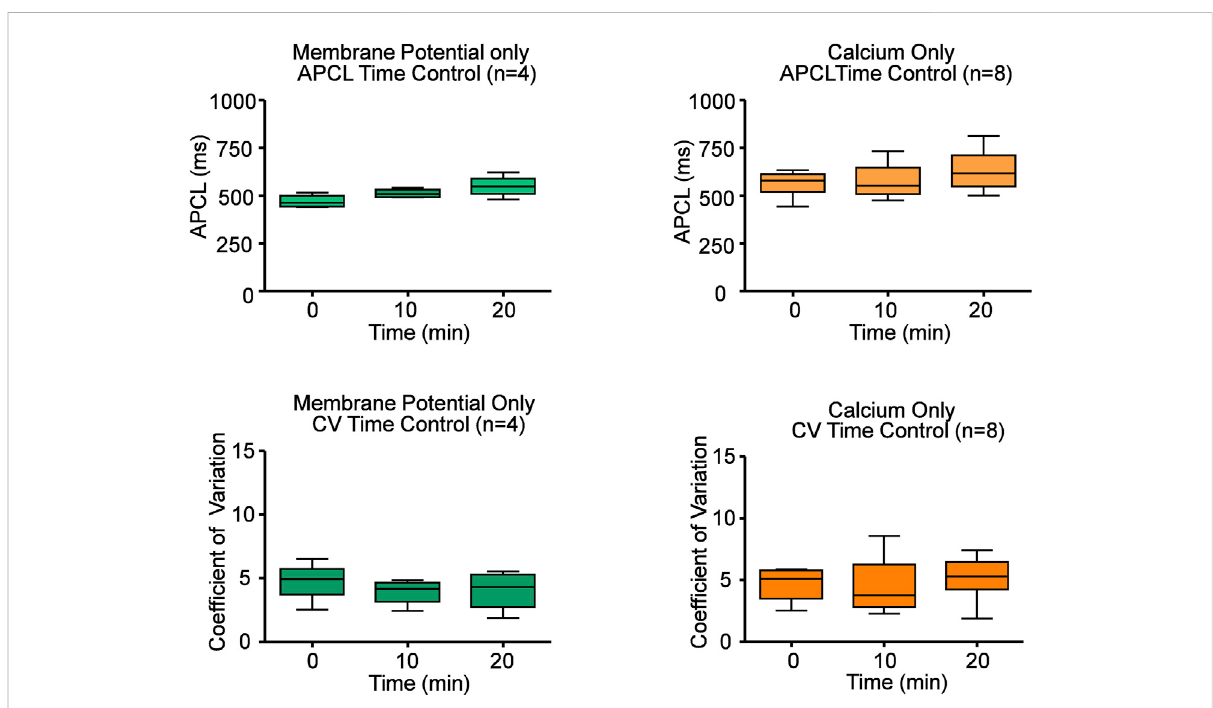
FIGURE 4 Time controls of Ca 2+ and electrophysiology measurements show that SANC action potential cycle length (APCL) and coef fi cient of variation (CV) do not change with time. Repeated measures ANOVAs of Ca 2+ and V m measurements showed there was no signi fi cant time effect on SANC fi ring rate and CV within twenty minutes. Based on this data, all experiments were performed within twenty